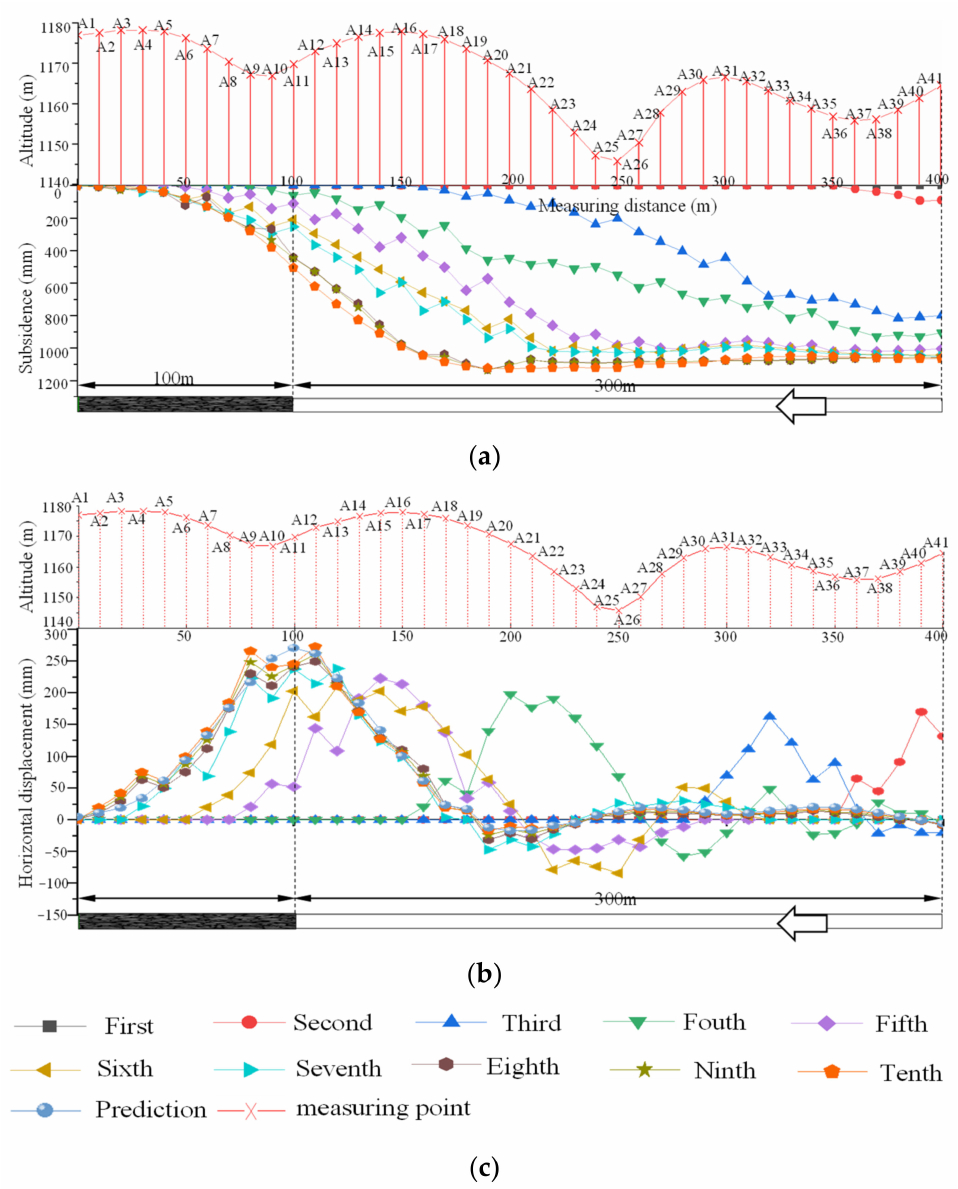
Figure 11. Surface movement deformation curve of mining under loess donga: ( a ) sinking curve, ( b ) horizontal movement curve, and ( c )